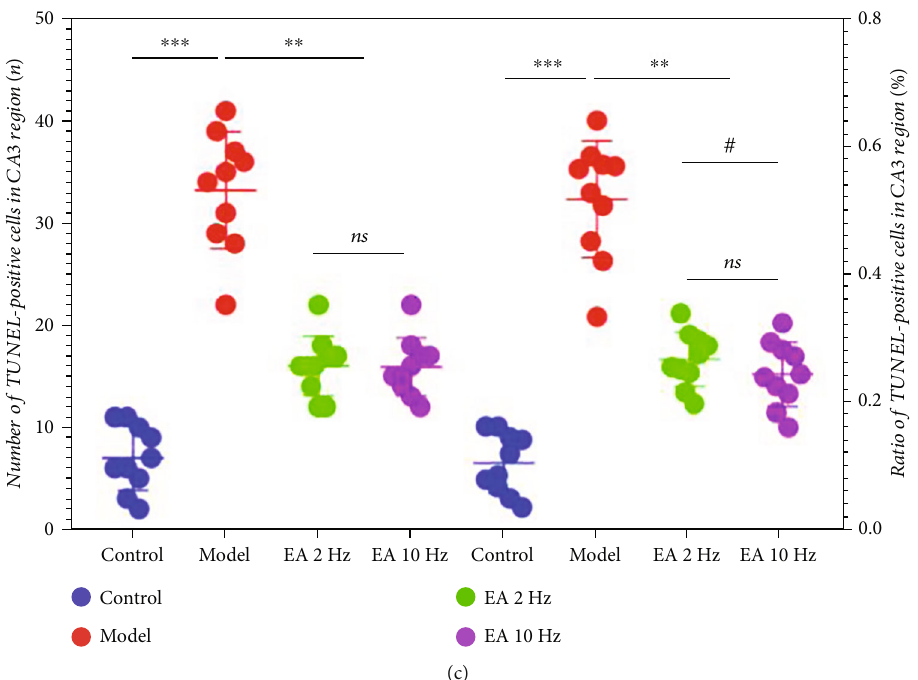
Figure 4: Electroacupuncture (EA) treatment limits neuronal cell death in the hippocampal CA1 and CA3 regions in SAMP8 mice. (a) Representative images of TUNEL staining in the hippocampal CA1 and CA3 regions from SAMR1 or SAMP8 mice. Magni fi cation, × 400, × 800, and × 1600. Scale bars, 50 μ m, 25 μ m, and 12.5 μ m. (b) The number and ratio of TUNEL-positive cells in the CA1 region. (c) The number and ratio of TUNEL-positive cells in the CA3 region. Data are the mean ± SD ( n = 10 per group). ∗∗∗ P < 0 : 001 and ∗∗ P < 0 : 01 vs. the model group; # P < 0 : 05 vs. the 2Hz EA group. ns: not signi fi